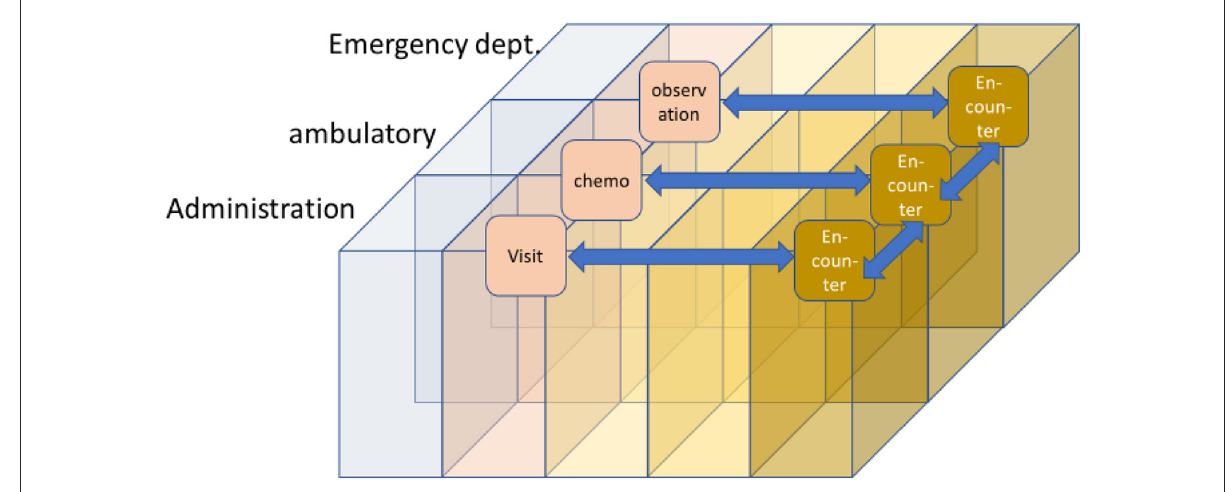
FIGURE19 Example representation of data using the FHIR encounter resource.